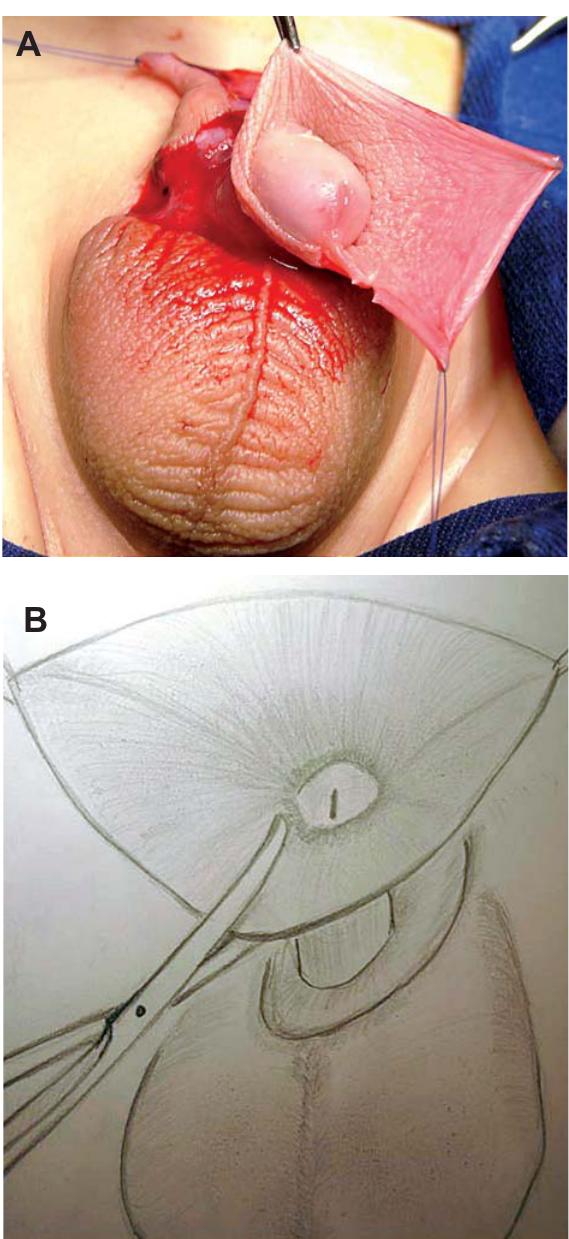
Figure 6 – A) Cutting the inner prepuce. B) Schematic draw- ing.